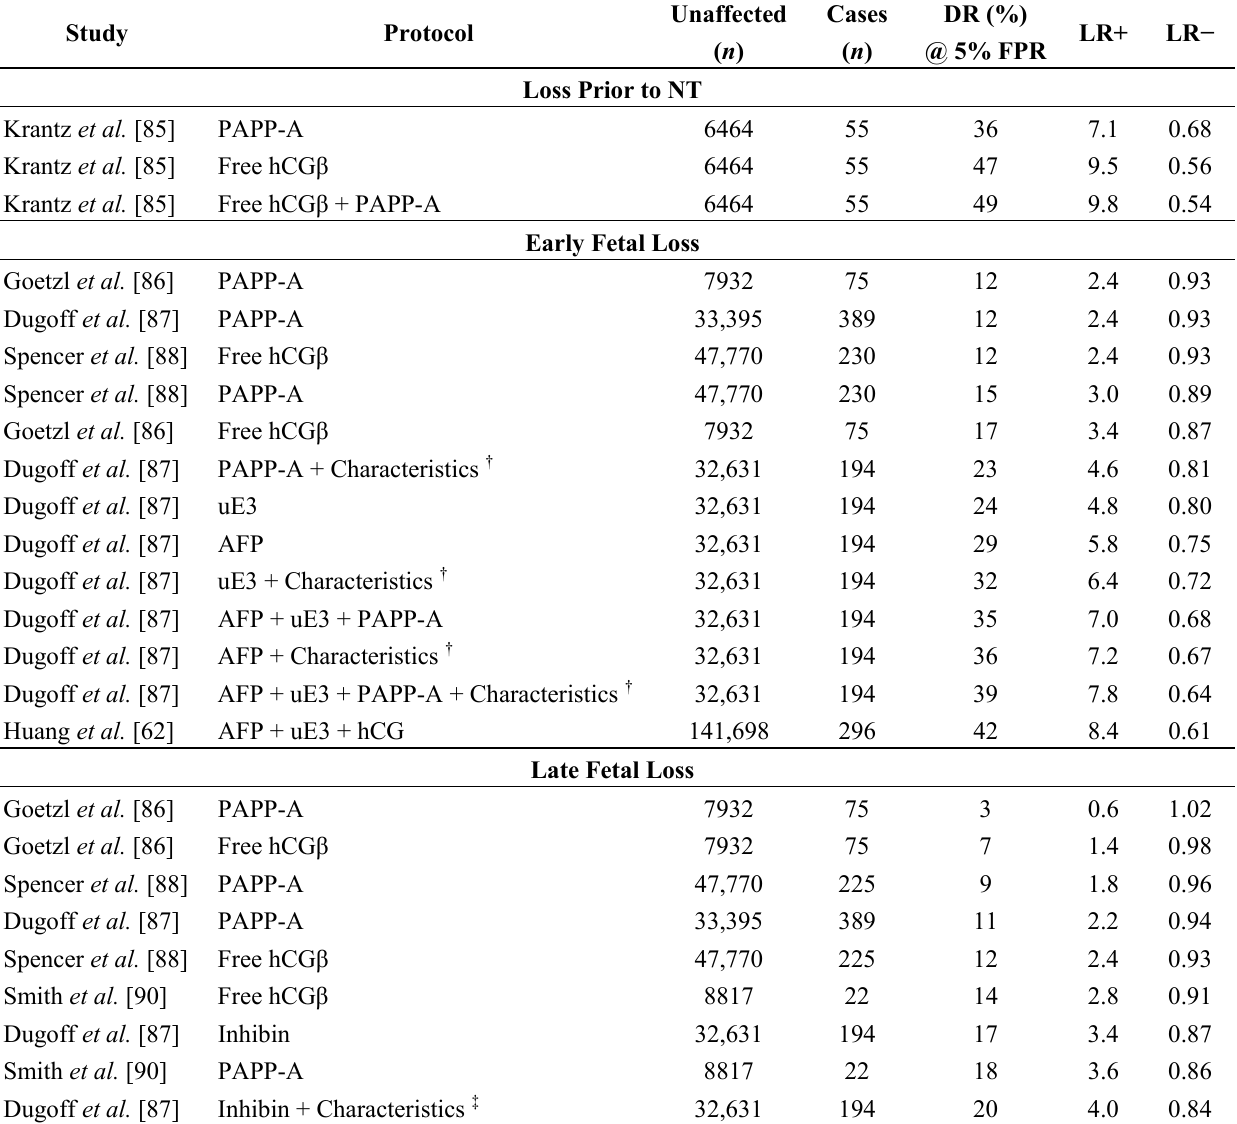
Table 3. Performance of screening marker protocols in identifying fetal